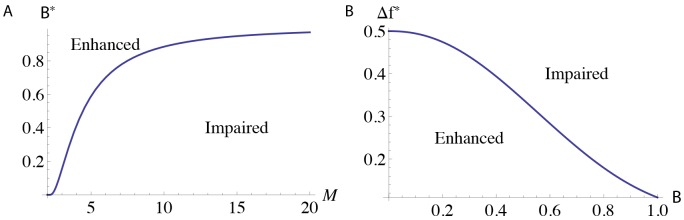
Regions of parameter space with different learning outcomes for the serial model.The functions (A) β*(M), which describes when the DKO models have impaired learning, and (B) Δf*(β,M) for M=10, which describes when pre-training enhances learning.